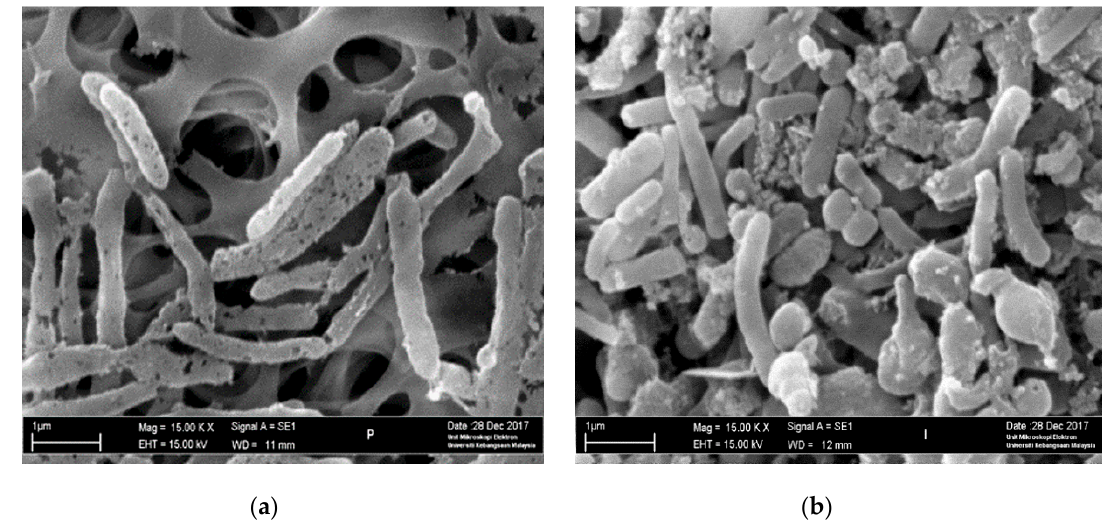
Figure 7. Photograph of scanning electron microscope (SEM) of the ( a ) thermophilic and ( b ) mesophilic conditions.